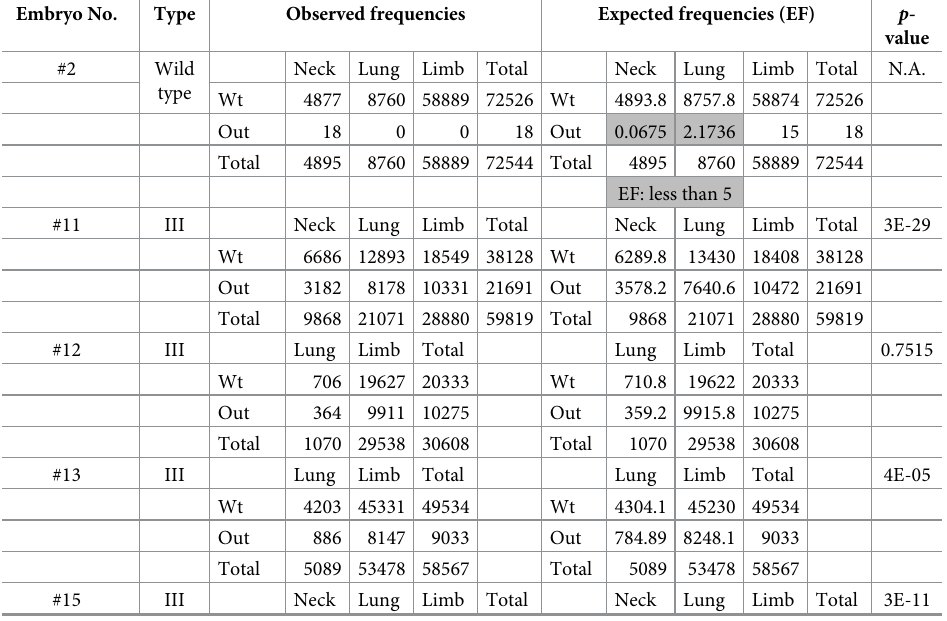
Table 4. Chi-square test for genotyping results of DNA derived from different tissues. Embryo No.